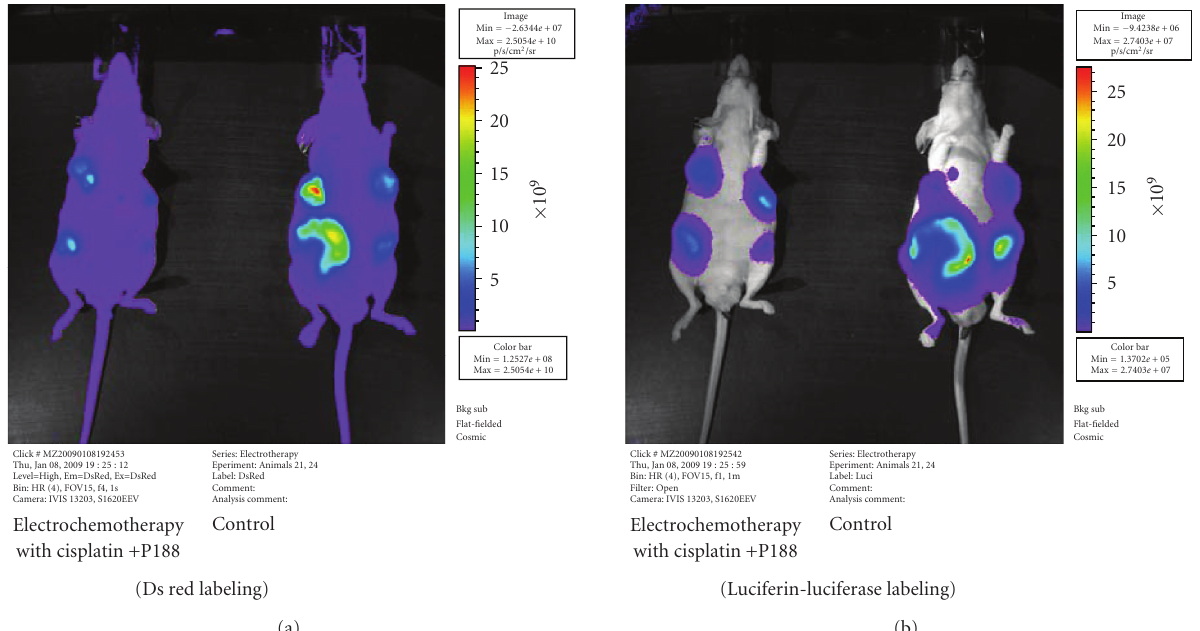
Figure 8: Visualisation of the HeLa tumors by (a) red fluorescence protein-Ds red and (b) luciferase/luciferin reaction by using an IVIS 100 system at 30 days after the first electrotreatment.